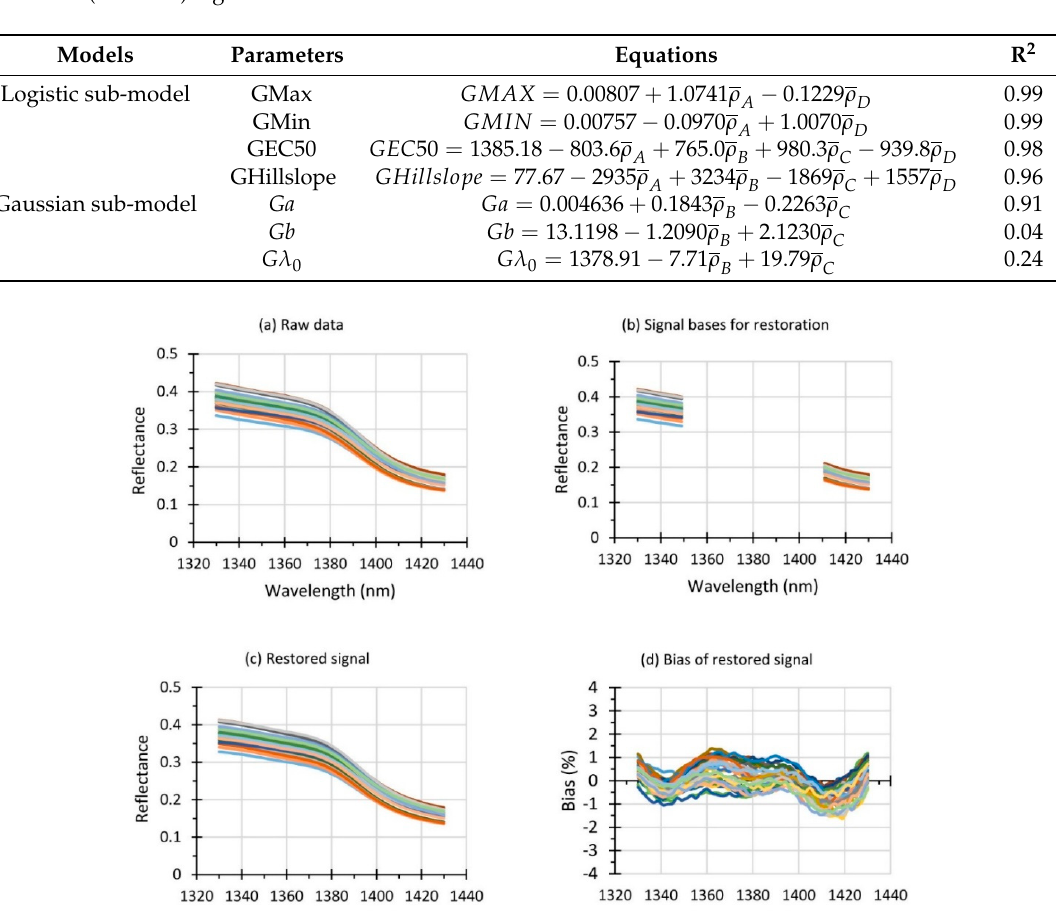
Figure 4. Example of the original laboratory based noise-free spectral reflectance in the SWIR segment ( a ); the bases for signal restoration ( b ); the generalized Logistic ‐ Gaussian complex signal model (GLGCM) method restored spectra ( c ) and bias ( d ) at each of the wavelengths.